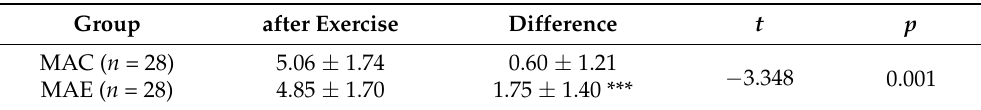
Table 5. Plasma NfL levels after exercise intervention and the amount of change in the MAC and MAE